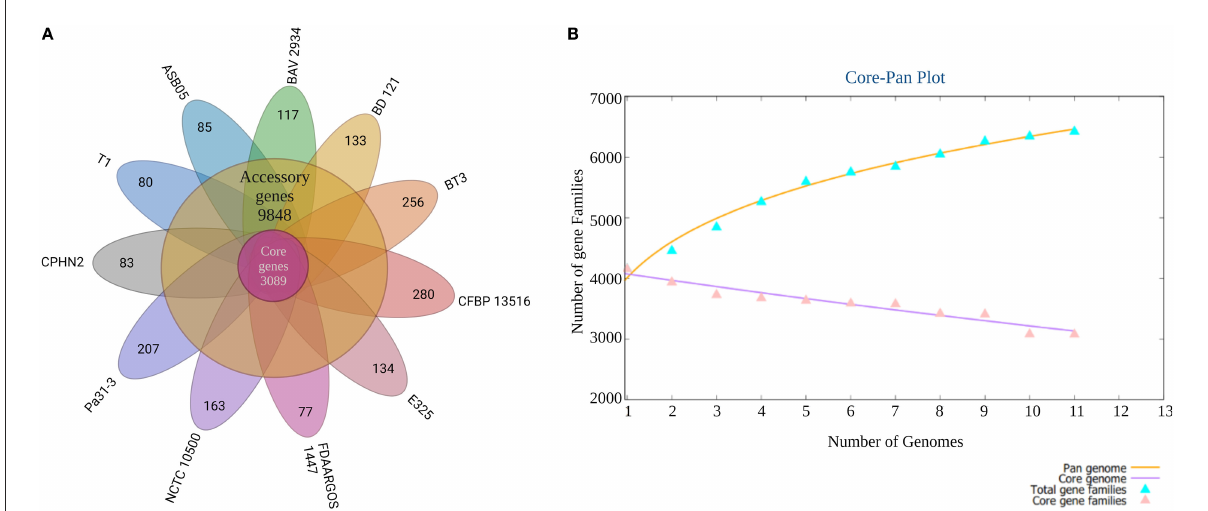
FIGURE4 A plot of the core/pan-genome of P. agglomerans strains and a Venn diagram of the core-genome and strain-specific coding sequences (CDS). (A) The number of distinct CDS for each strain of the pan-genome of P. agglomerans . (B) Genome comparisons using n = 11 genomes were performed to identify the core-genome and strain-specific CDS for the 11 P. agglomerans strains sequenced.